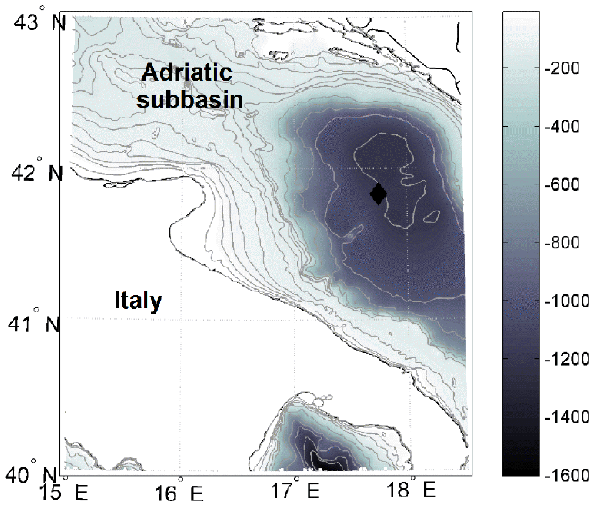
Fig. 11. Location of the monitoring site in the southern Adriatic.